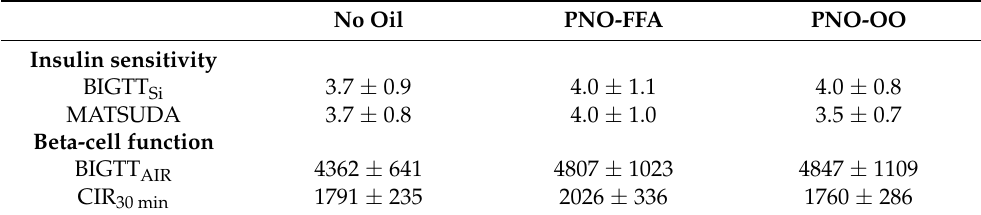
Table 2. OGTT based indices on insulin sensitivity and beta-cell function.